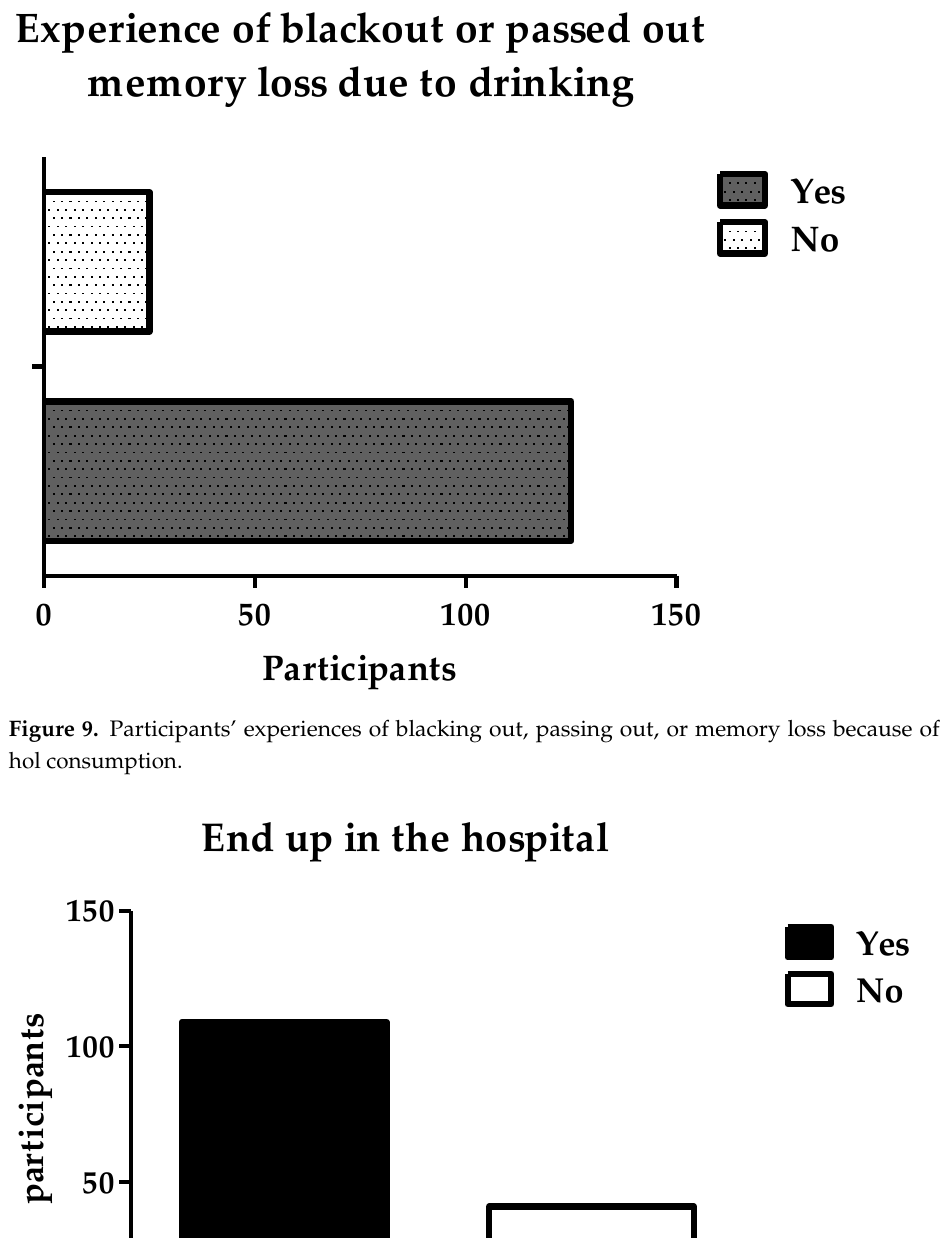
Figure 9. Participants’ experiences of blacking out, passing out, or memory loss because of alcohol consumption.